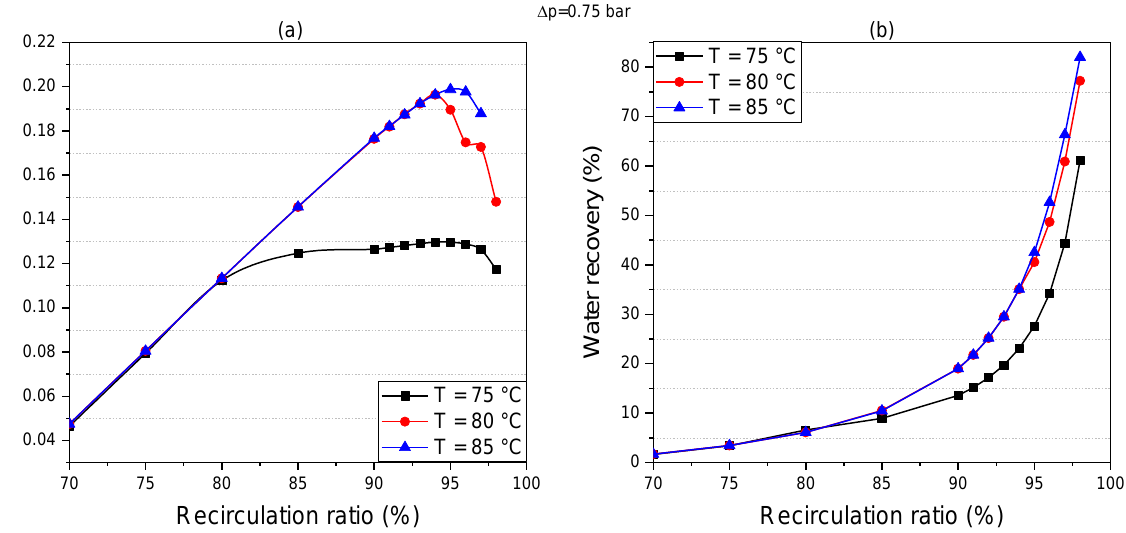
Figure 5. Water production ( a ) and percentage of water recovery of the flash evaporation ( b ) as recirculation ratio increases, for three different set-points of the heat pump.